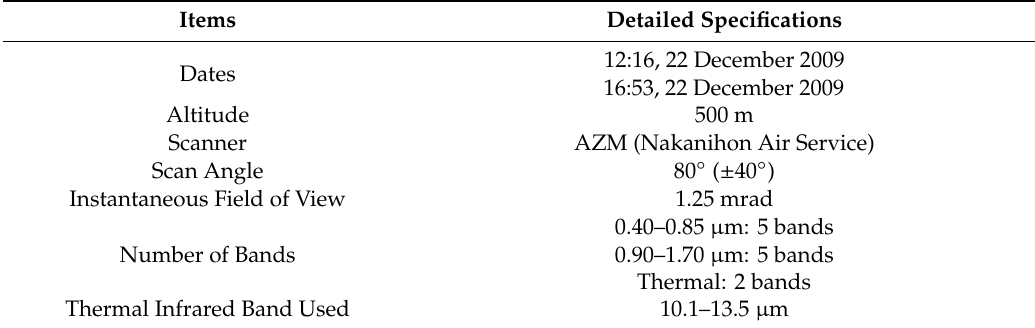
Table 1. Specifications of remote sensing observations.